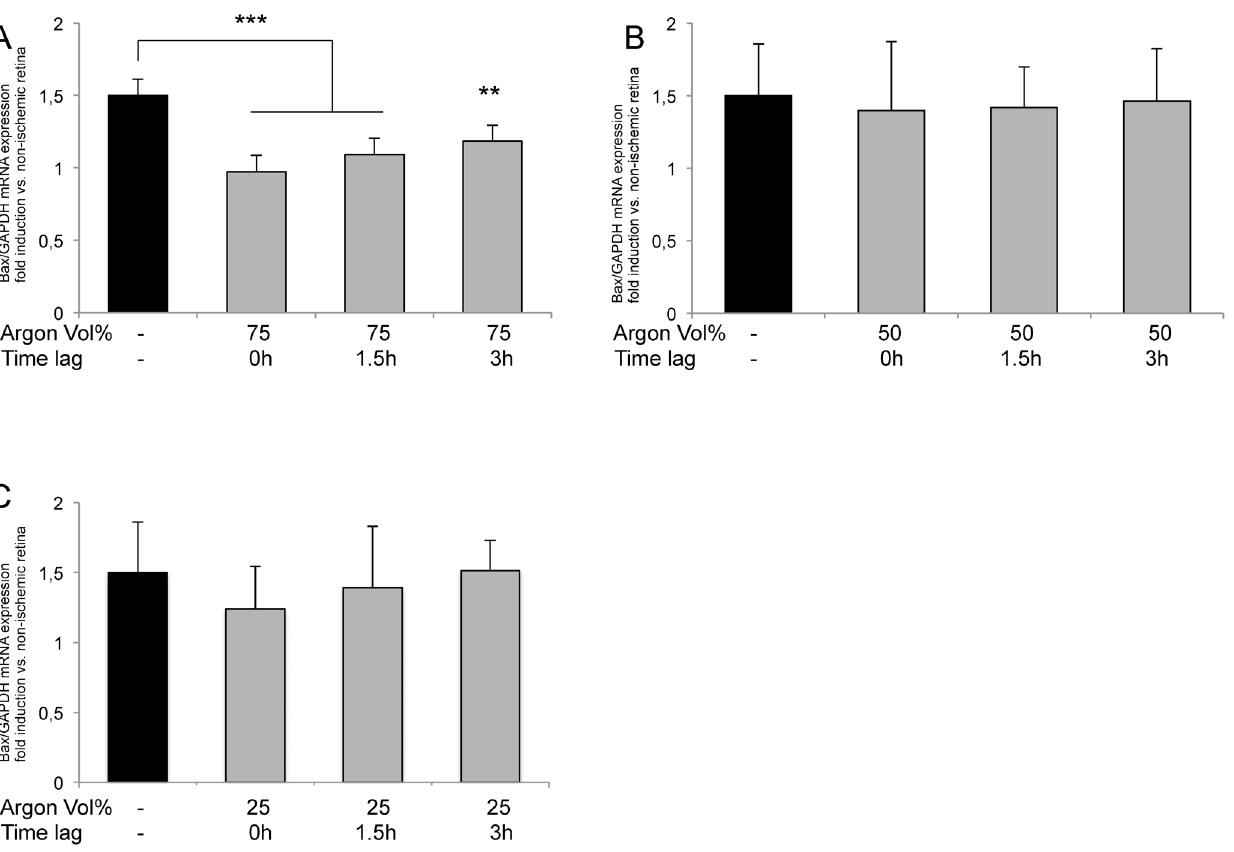
Fig. 4. Effect of Argon inhalation on retinal expression of Bax mRNA. Fold induction of Bax mRNA expression in ischemic retinal tissue compared to GAPDH in relation to the corresponding non-ischemic retinae analyzed by RT-PCR after (A) 75 Vol% Argon inhalation, (B) 50 Vol% Argon inhalation and (C) 25 Vol% Argon inhalation; (n 5 8; data are mean ¡ SD; *** 5 p , 0.001 IRI vs. IRI + Argon 75 Vol% immediately and IRI + Argon 75 Vol% at 1.5 h delayed treatment, ** 5 p , 0.01 IRI vs. IRI + Argon 75 Vol% at 3 h delayed treatment).